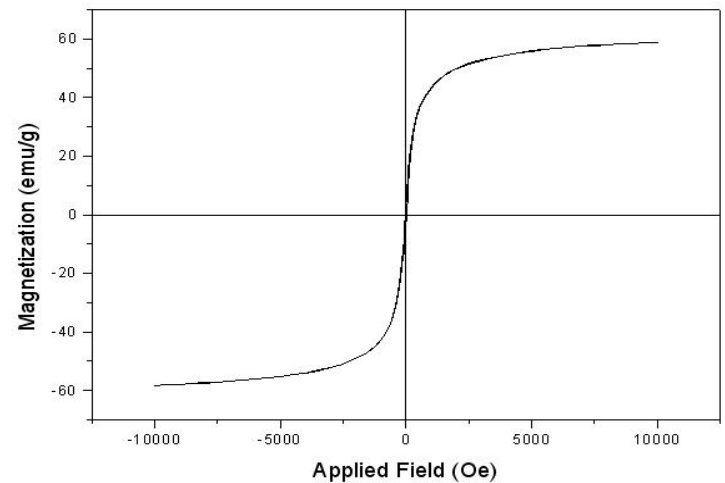
Fig. 10. Magnetic intensity measurement curve of Fe